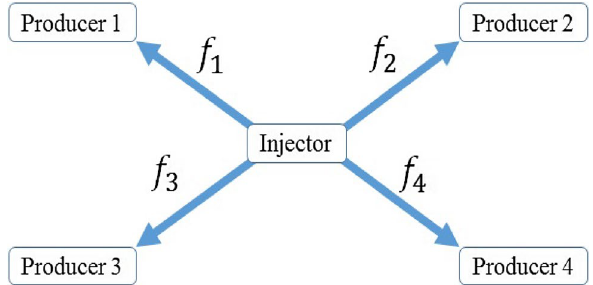
Fig. 9 The schematic of the CRMP model in the synthetic